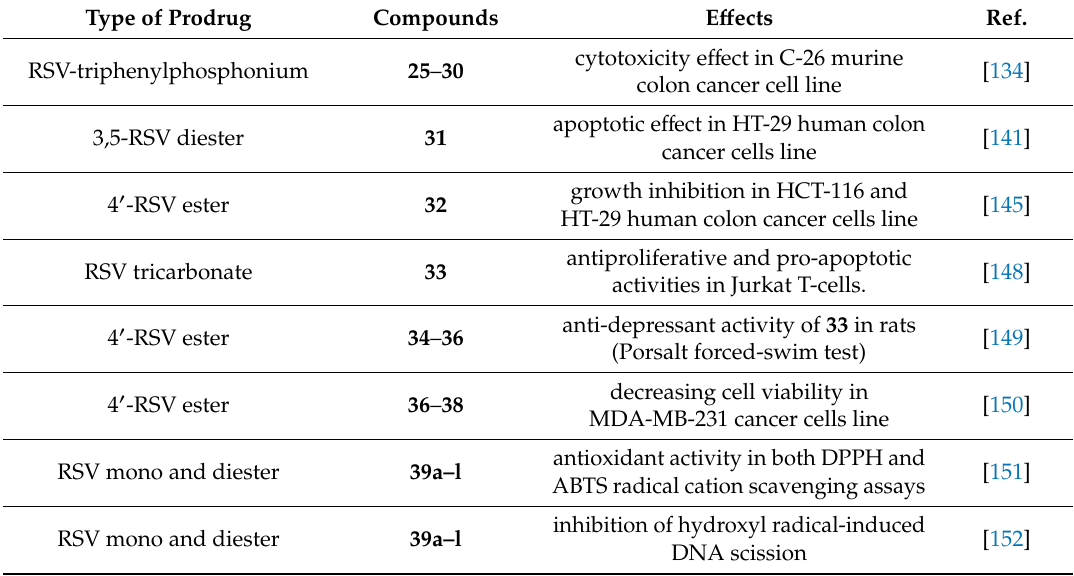
Table 6. Summary of RSV prodrugs for systemic delivery and their biological e ff